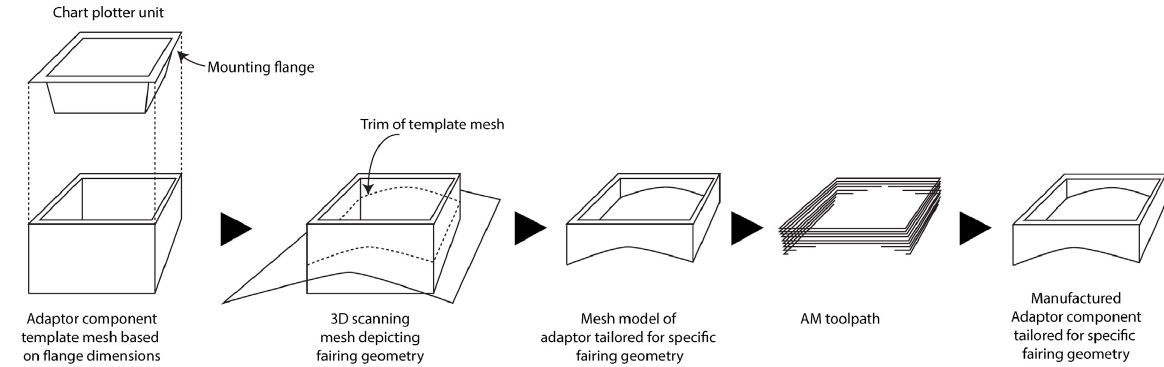
Figure 3: An overview of the mass customization process that combines 3D scanning, mesh modeling, and AM.